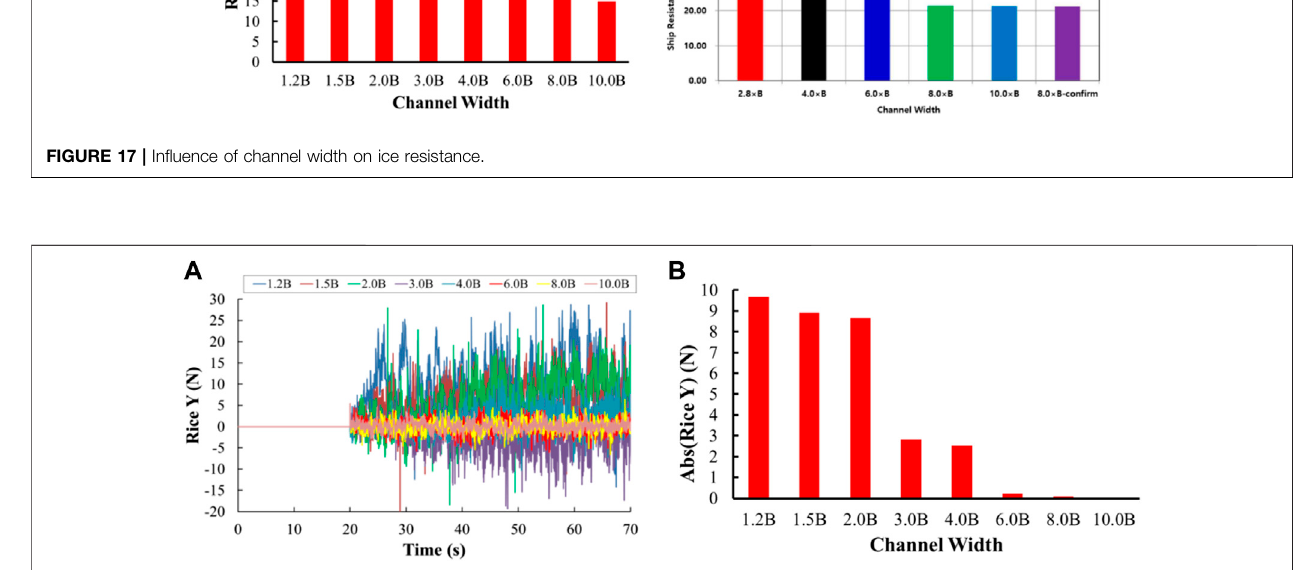
FIGURE 18 | Transverse force.